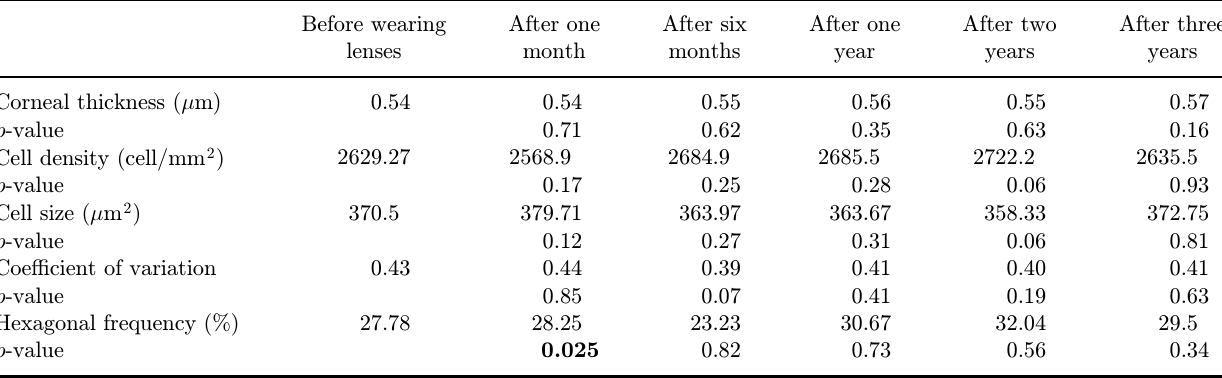
Table 2. The results from Group 2: parameters of the corneal physiology (corneal thickness and endothelial morphology).